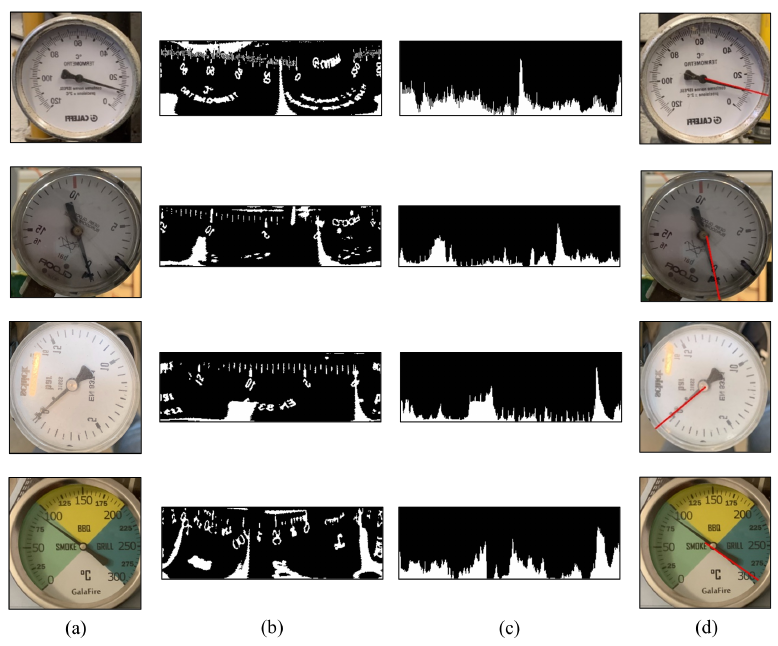
Figure 12. Application of the pointer detection using pixel projection. ( a ) RoI, ( b ) polar transformation, ( c ) pixel projection, ( d ) pointer detection.